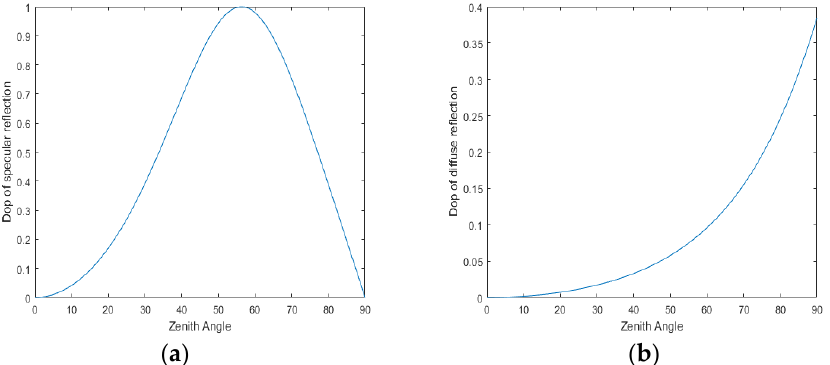
Figure 4. Relationship between zenith angle and physical model. ( a ) Specular reflection. ( b ) Diffuse reflection.